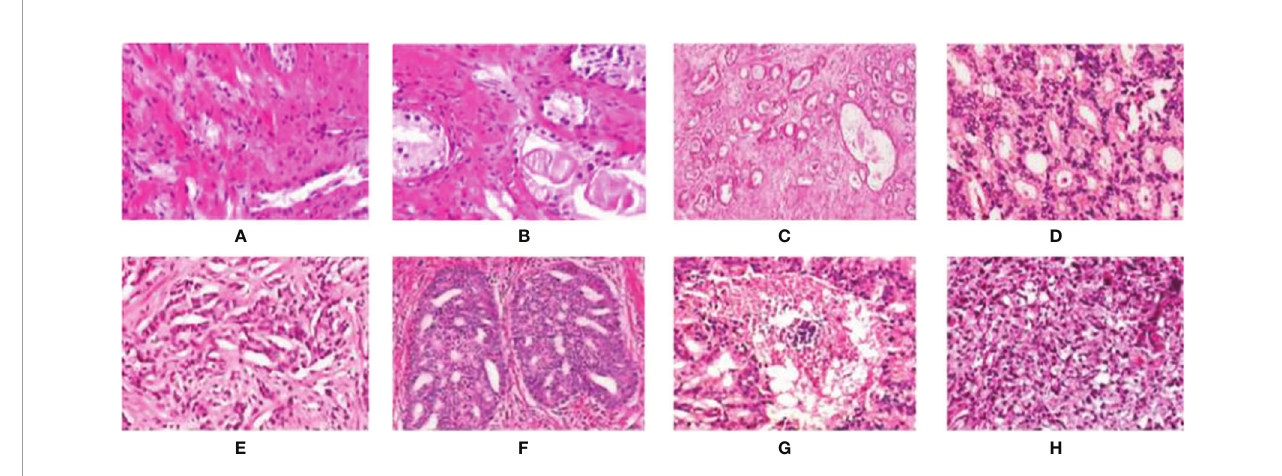
FIGURE 3 | Examples of digital histopathology images for Prostate Gleason Grading. We list four different Gleason grade groups: (A, B) Benign; (C, D) Grade 3; (E, F) Grade4; and (G, H) Grade 5. It can be observed that each level has a variety of sizes, shapes, and irregular object boundaries. Gleason Grade 3 consists of well-formed and well-de fi ned glands with varying sizes but which are smaller and tighter than non-cancerous prostatic tissue. While Gleason Grade 4 is associated with poorly formed glands, gland fusion is no longer separated by the matrix, even related to a pattern known as cribriform. Gleason Grade 5 includes the worst differentiated